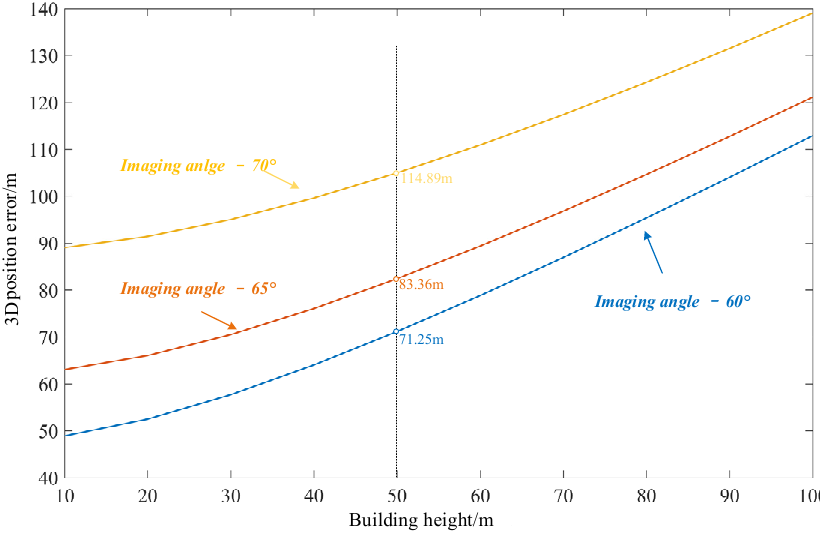
Figure 13. Error caused by the height of the target on the building.